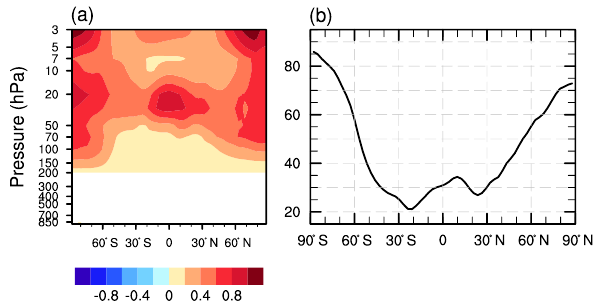
Figure 1. The distribution of SOR. (a) The vertical cross section of the annual and zonal mean difference of ozone, unit: ppmv. (b) The annual and zonal mean difference of total column ozone, unit: DU.